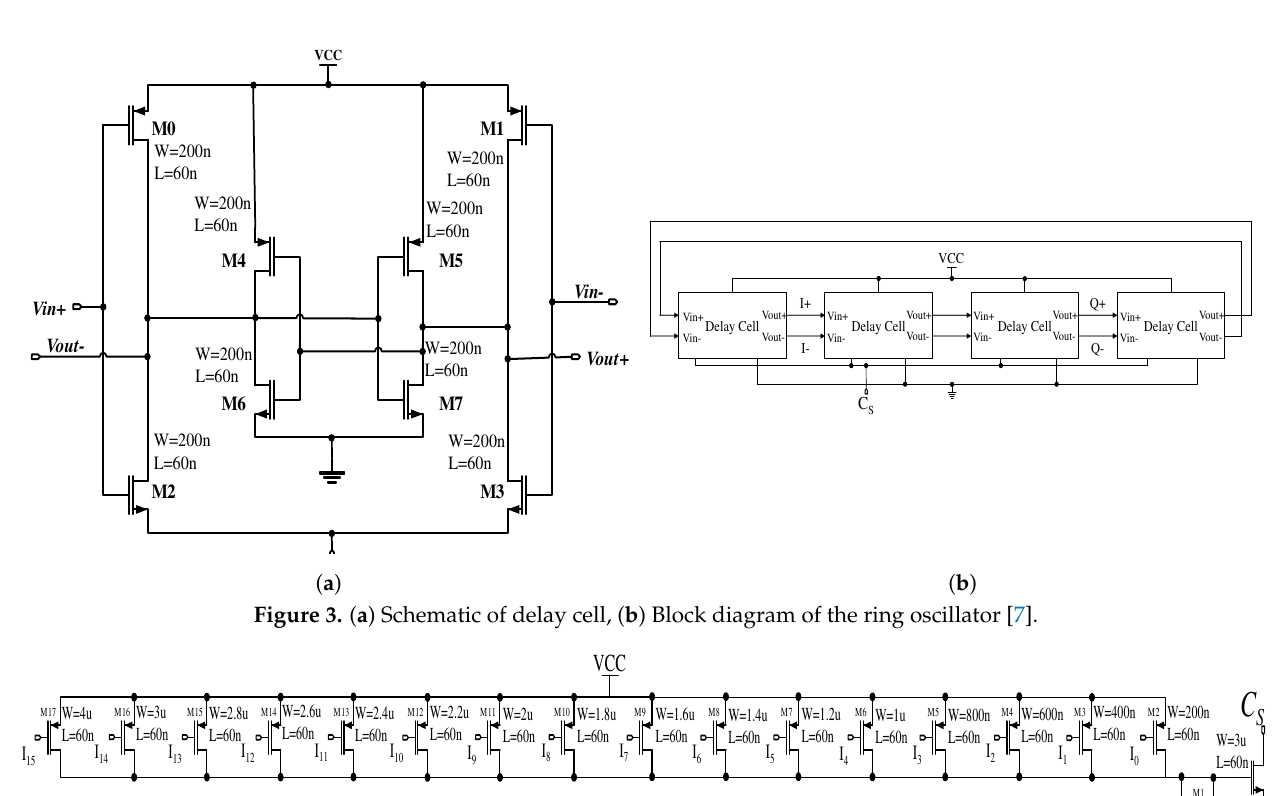
Figure 4. Schematic of the DAC [7].